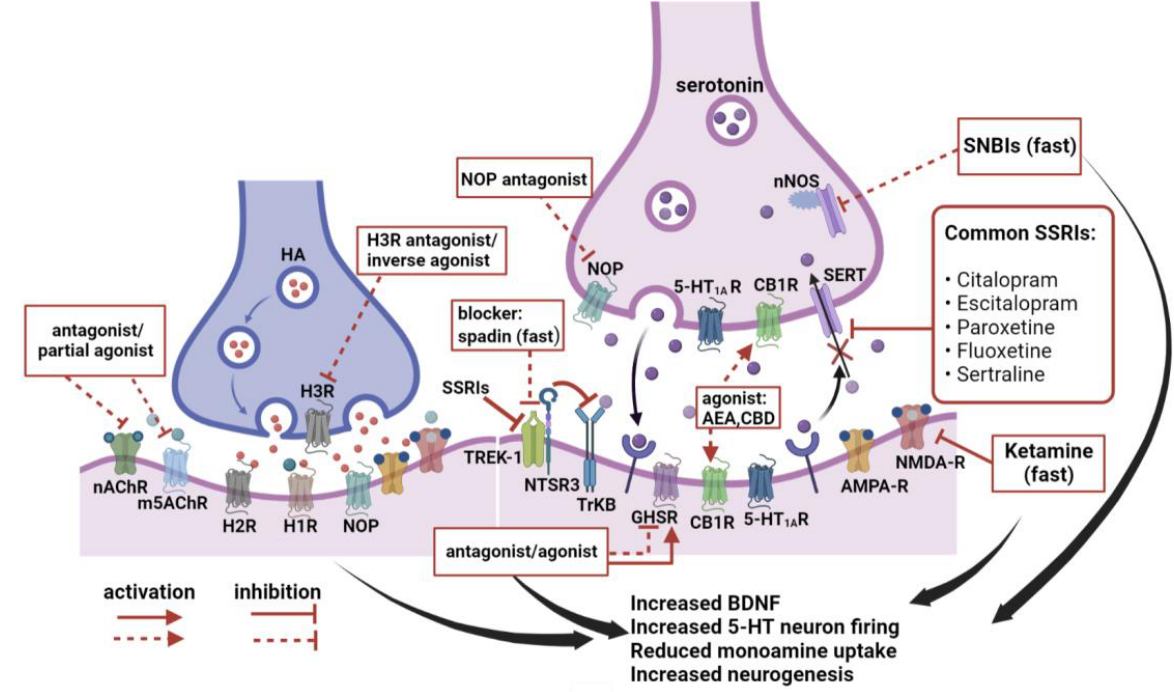
Figure 3. Schematic diagram summarizing potential targets for antidepressants. SSRIs and ketamine are currently available antidepressants; their pharmacological targets are indicated by the solid red line. Other potential targets, including nAchR, m5AchR, TREK-1, GHSR, CB1R, and presynaptic H3R, NOP, and SERT-nNOS, are indicated by the dotted red line. Compounds with antidepressant effects are indicated as antagonists, agonists or blockers. Abbreviations: HA, histamine; NOP, nociceptin opioid peptide receptor; TREK-1, TWIK-related K + Channel 1; NTSR3, neurotensin receptor 3, also known as sortilin; GHSR, growth hormone secretory receptor; CB1R, cannabinoid receptor